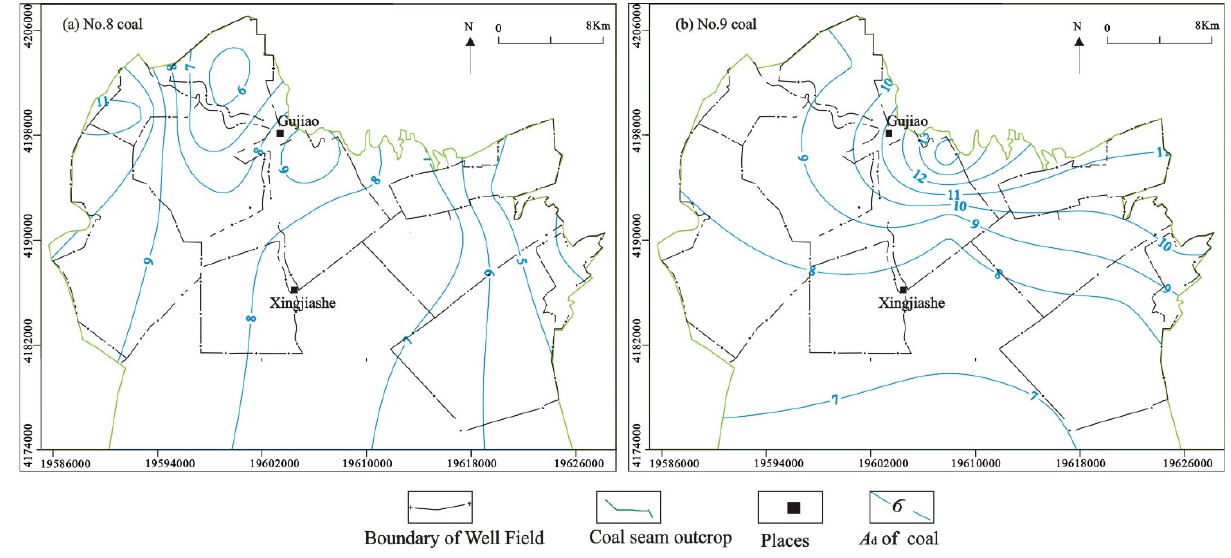
Figure 3. Contour map of coal ash yield.